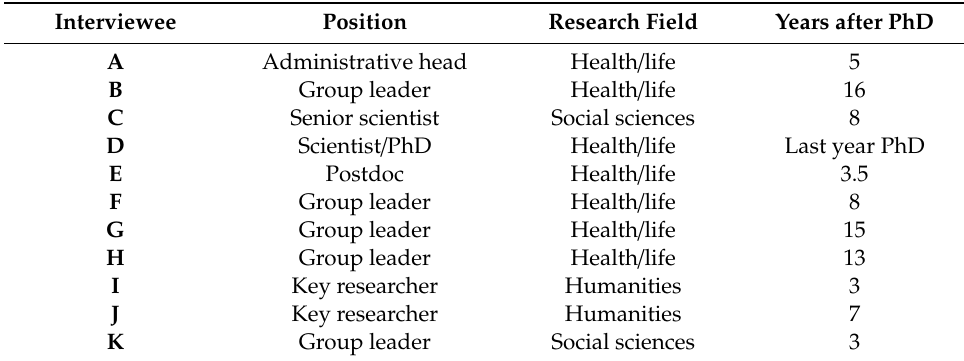
Table 1. Interviewee